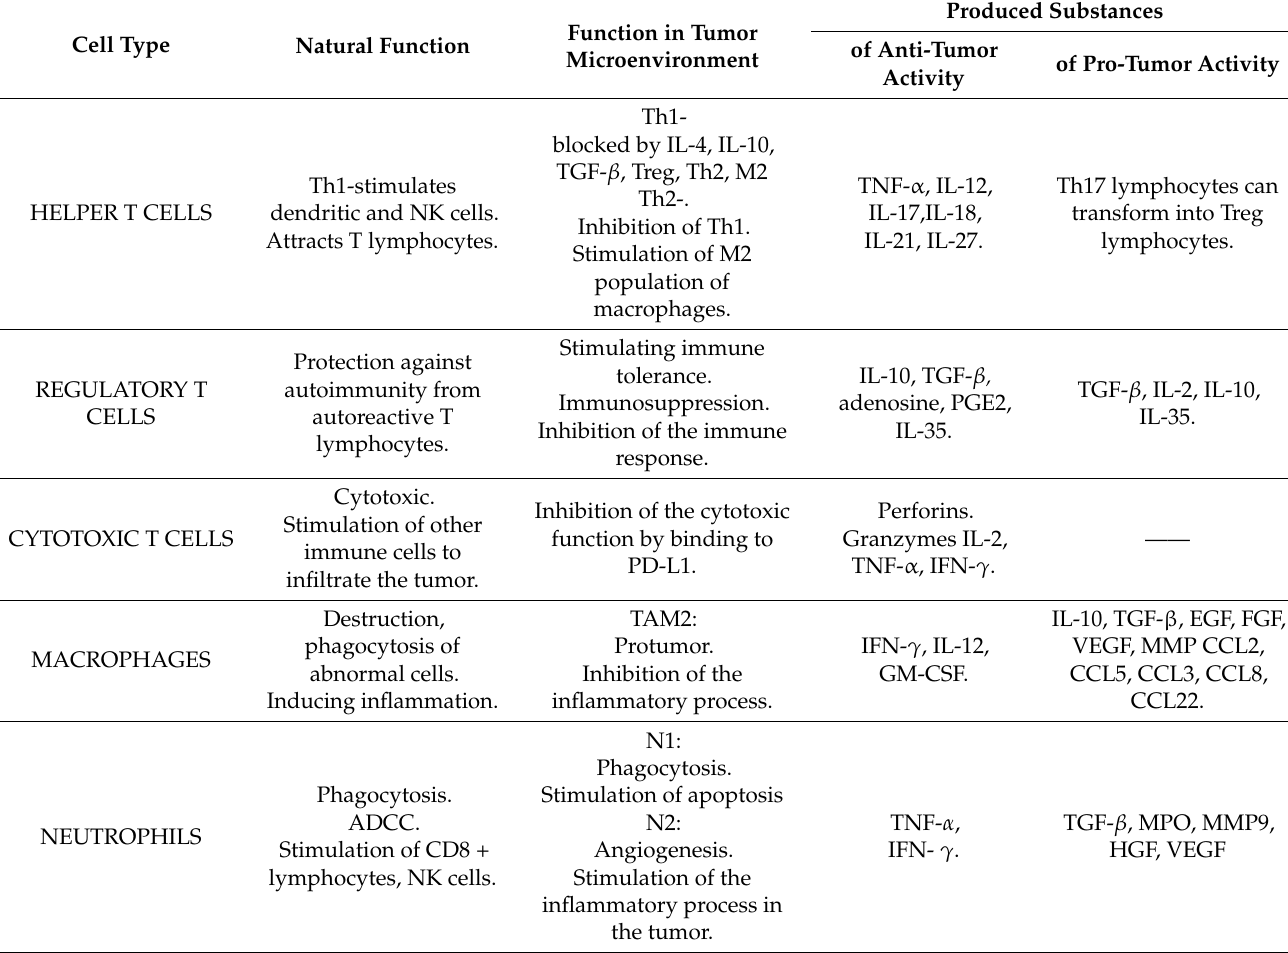
Table 2. Different cell populations in the tumor microenvironment